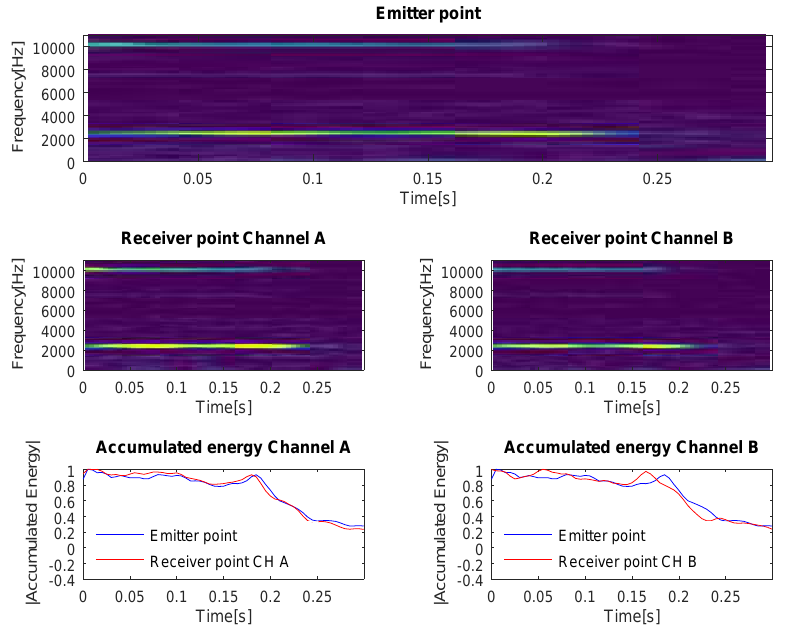
Figure 3. Anomalous noise event labeled as a horn. The spectrogram of the emitted signal in the upper plot; in the mid-left plot, the spectrogram of the received signal through Channel A; in the mid-right plot, the spectrogram of the received signal through Channel B; in the lower-left plot, the accumulated energy through Channel A; and in the lower-right plot, the accumulated energy through Channel